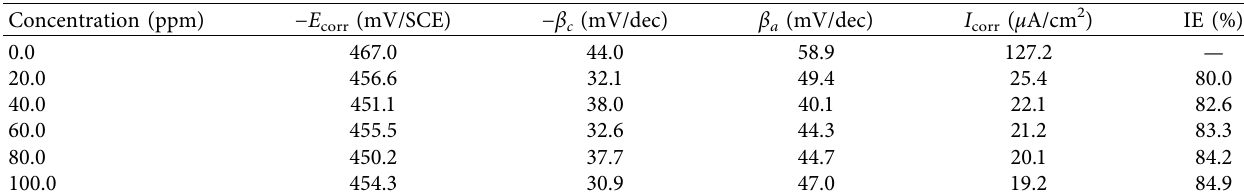
Table 1: Corrosion descriptors obtained from the polarization test at 298K. Concentration (ppm)